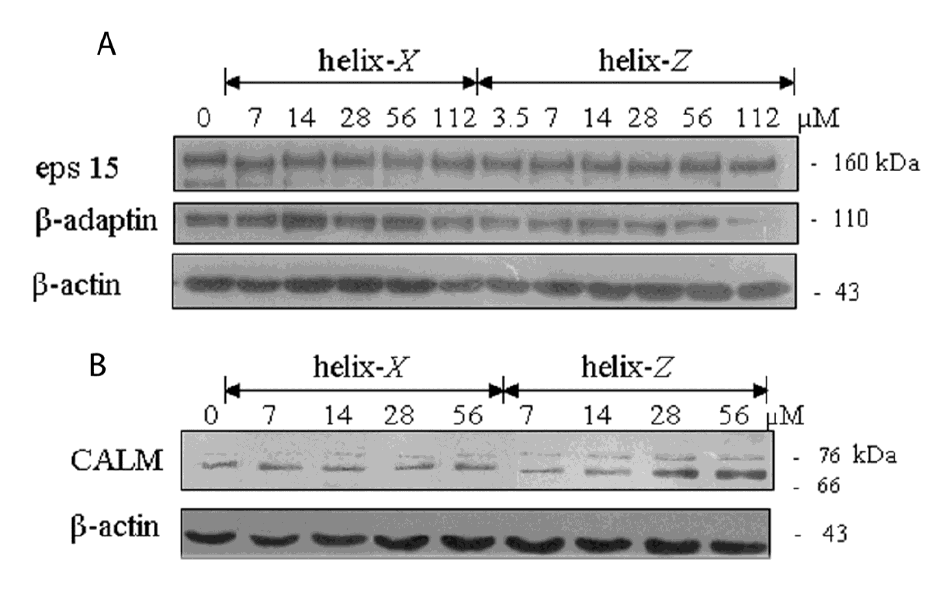
Figure 7. Endocytic protein expression in microglial cells treated with helix- X and helix- Z . Both peptides were previously incubated 120 h at 37 °C. ( A ) Western blot analysis of eps 15 and β–adaptin; ( B ) Western blot analysis of clathrin assembly lymphoid myeloid leukemia (CALM) protein. β-actin was used as loading